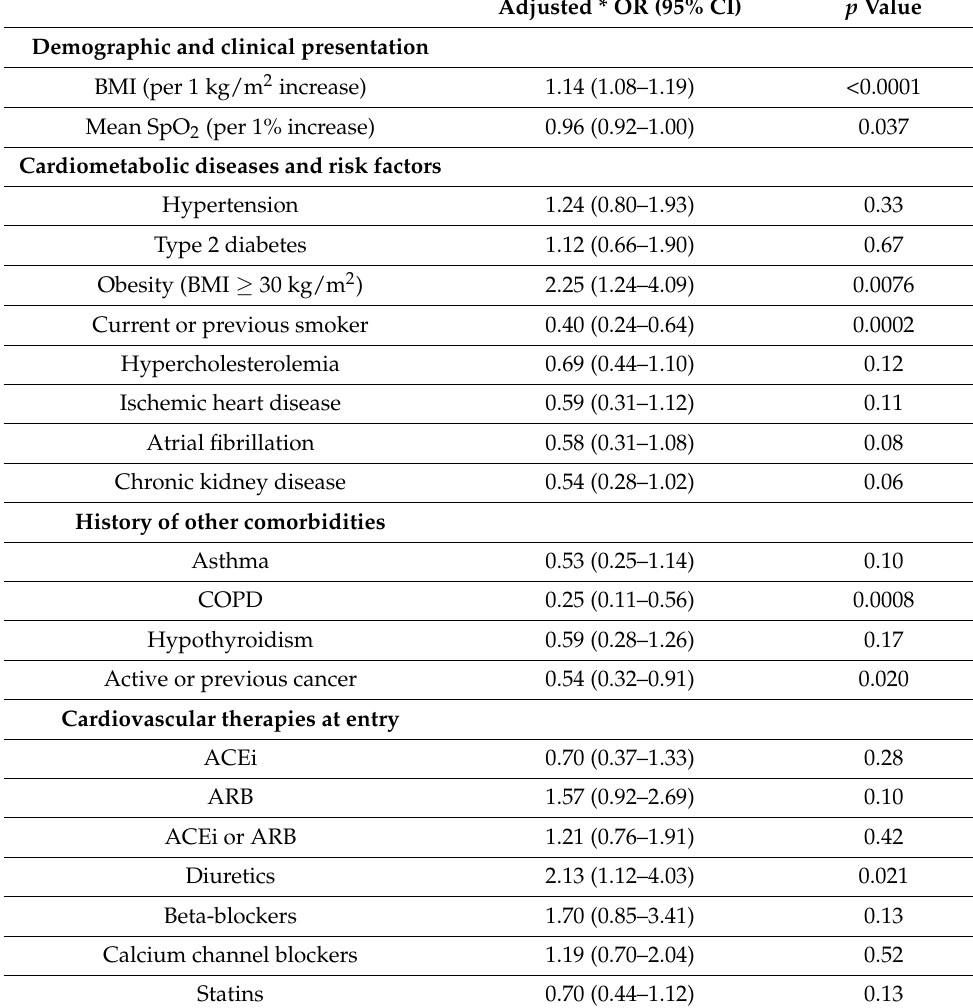
Table 3. Comparison of characteristics between patients hospitalized with COVID-19 and